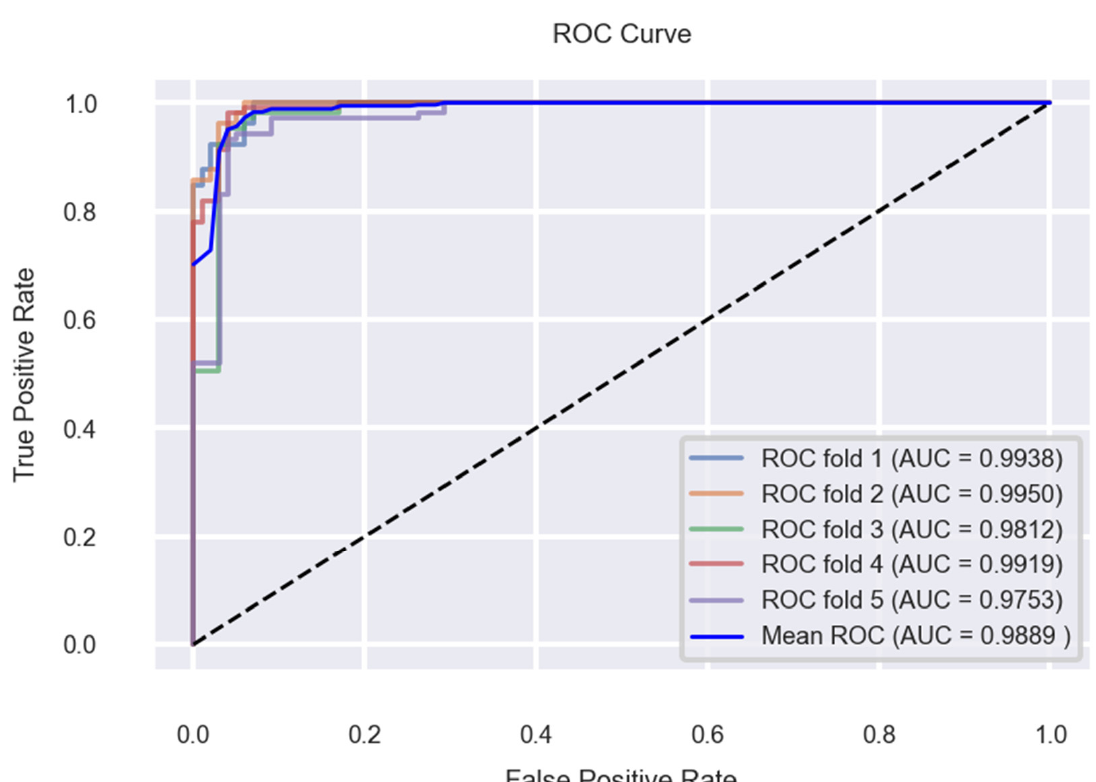
Figure 24. Stratified (K = 5)-Fold Cross-validation Results for Artificial neural network (ROC-AUC).